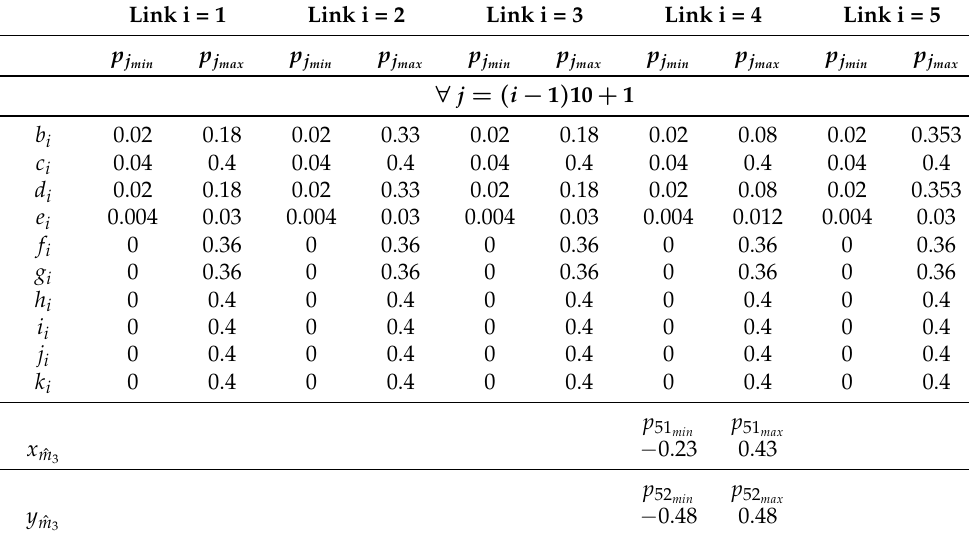
Table 2. Boundaries of the design variable